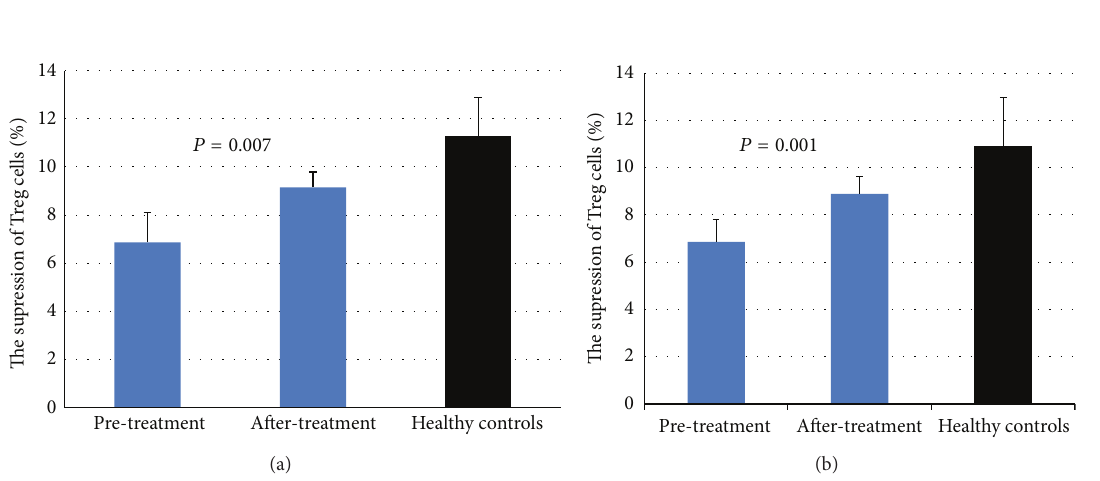
Figure 2: The suppressive activity of Treg cells before and after the treatment in the experimental group; (a) the suppressive ability for CD4 + T cells; (b) the suppressive ability for CD8 + T cells. The pretreatment baseline levels of Treg cells suppression was significantly lower for CD4 + cells and CD8 + cells than those in the healthy controls ( 6.87 ± 1.24 % versus 11.28 ± 1.60 %, 𝑃 < 0.001 ; 6.86 ± 0.95 % versus 10. 93 ± 2.04 %, 𝑃 < 0.005 ). Following the rapamycin treatment, the suppression for CD4 + cells ( 9.15 ± 0.64 %, 𝑃 = 0.007 ) and CD8 + cells ( 8.89 ± 0.73 %, 𝑃 = 0.001 ) was stronger than that before the